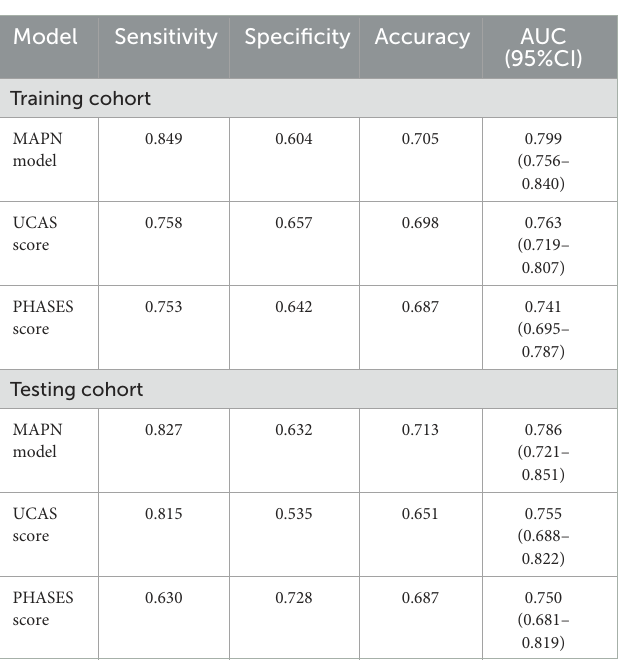
TABLE 3 Performance of each model in training cohort and testing